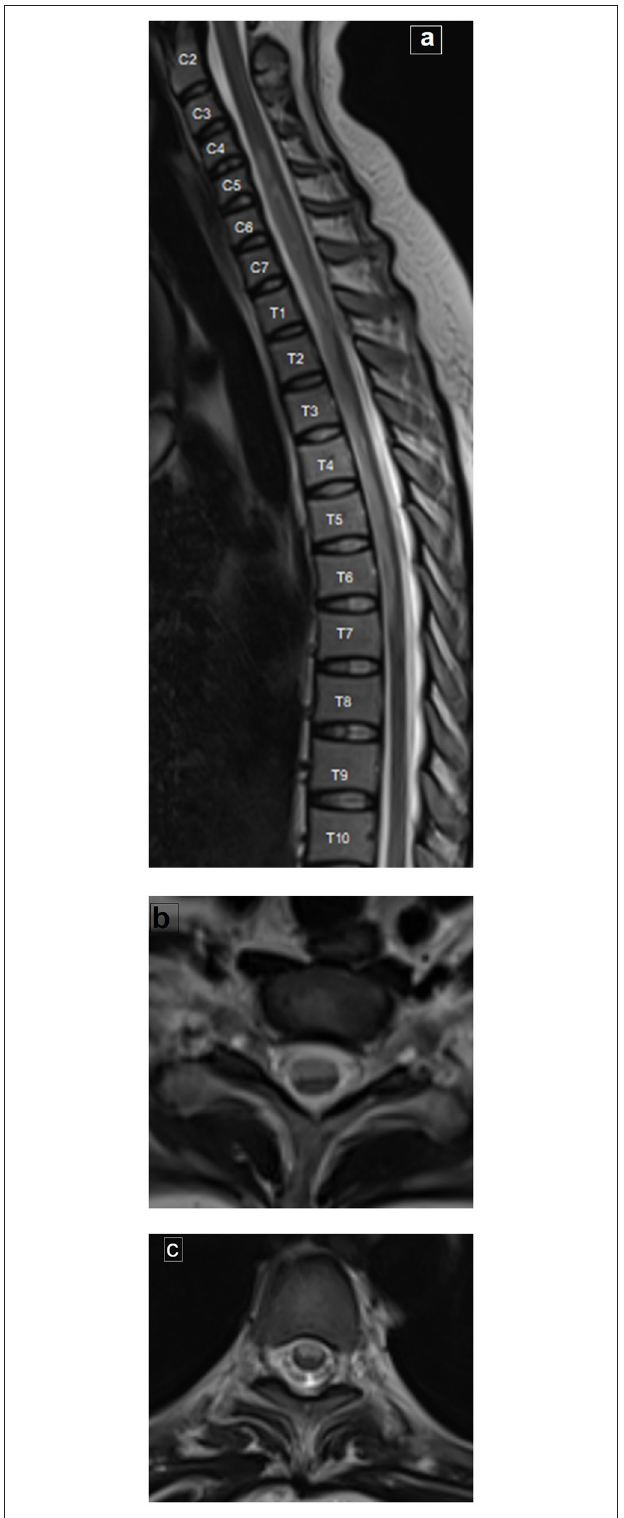
FIGURE 2 | MRI of the spine. (a) Sagittal T2-weighted image of the whole spine shows extensive long hyperintense signal extending from C5 to